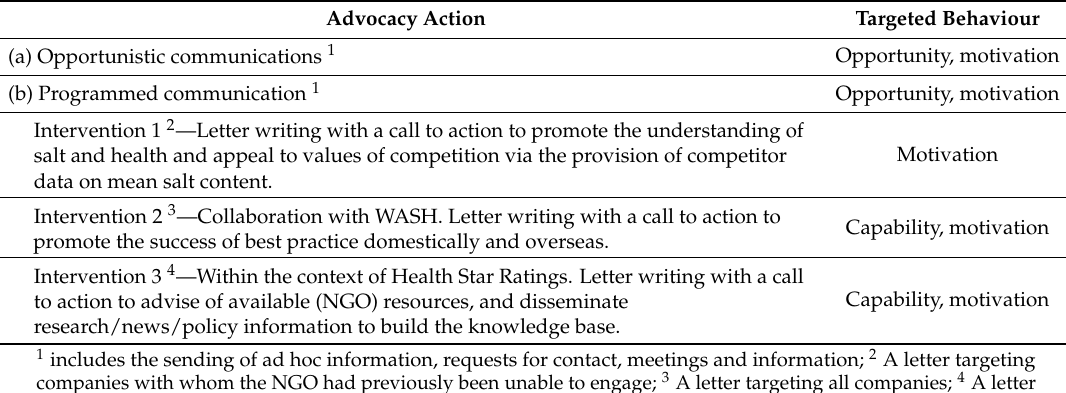
Table 1. Summary of the interventions and targeted organizational behaviour (capability, opportunity, and